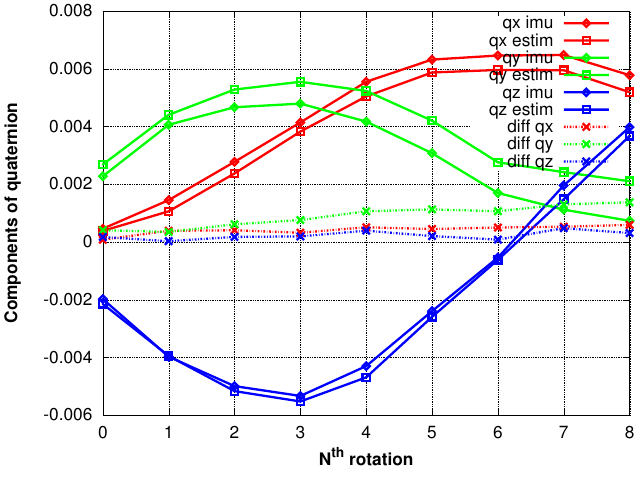
Figure 13. The two 3D rotations of the camera between